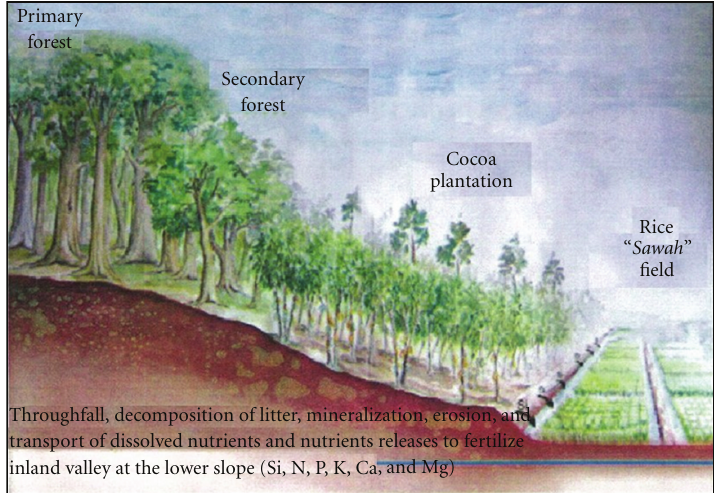
Figure 3: A typical example of African SATO-YAMA Concept developed by the Forest Research Institute of Ghana, after Owusu-Sekyere et al. [47].